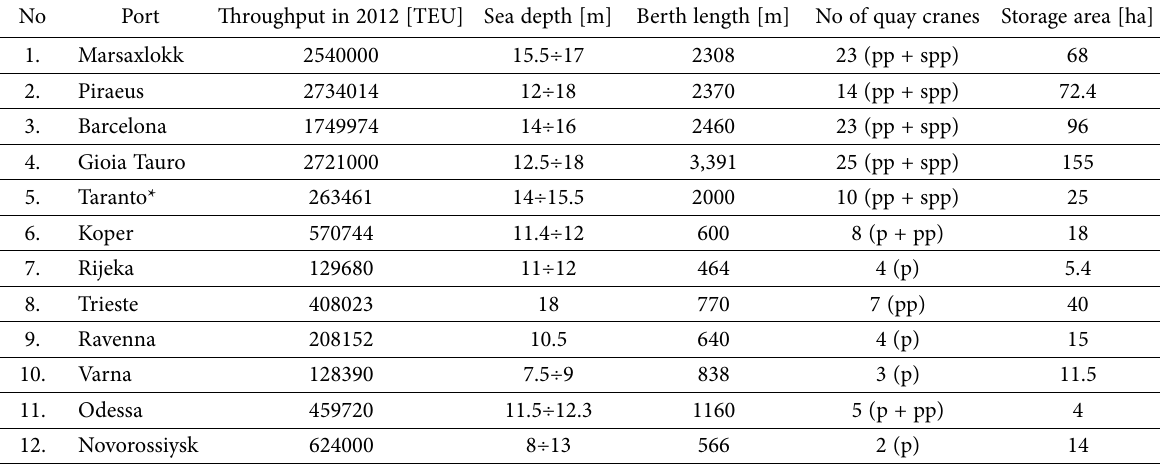
Table 1. Technical characteristics of the